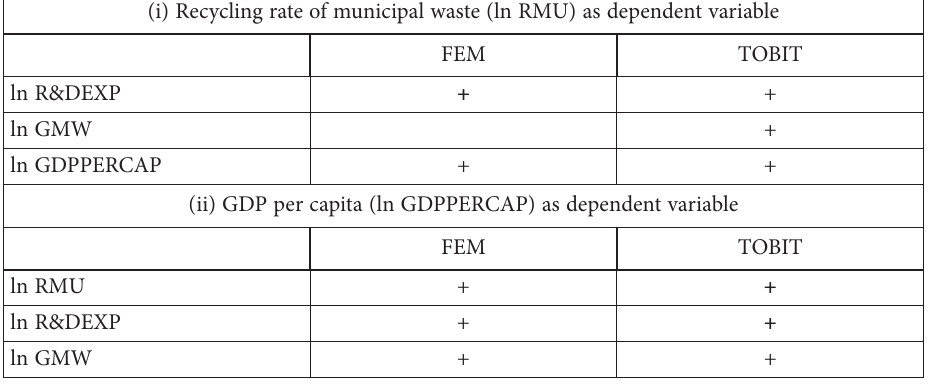
Table 13. Statistically significant determinants of municipal waste and economic growth